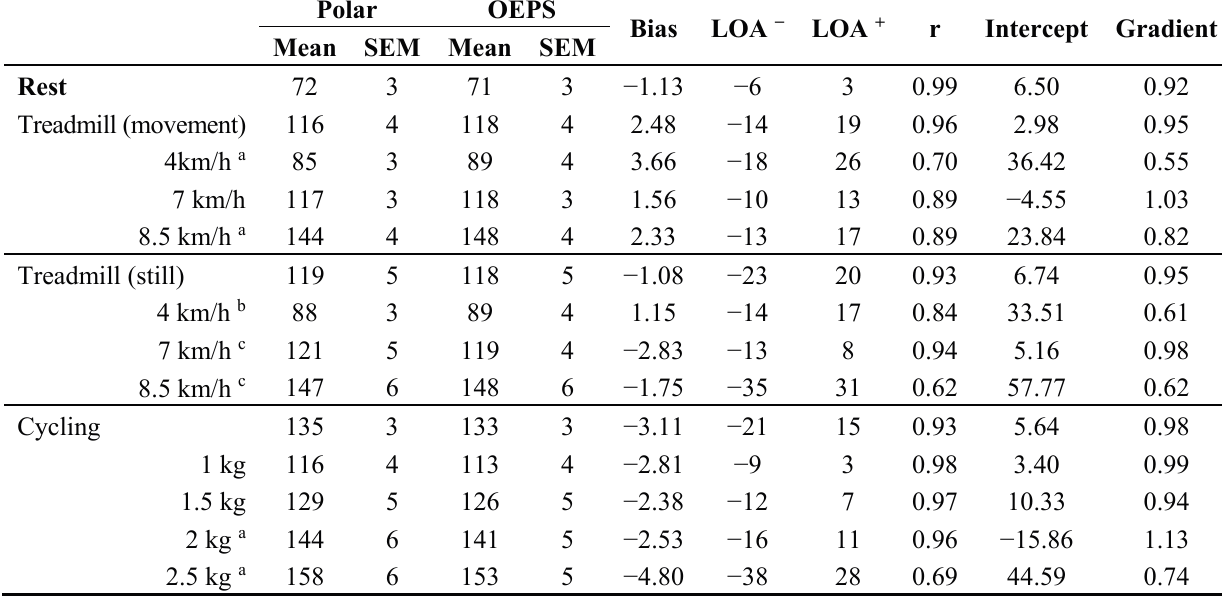
Table 1. Bias, 95% limits of agreement (LOA) and correlation coefficient (r) of HR between Polar and the OEPS during Rest, Walking, Running and Cycling Activity, number of subjects ( n = 16). Student paired t-tests for HR between Polar and the OEPS. Polar OEPS